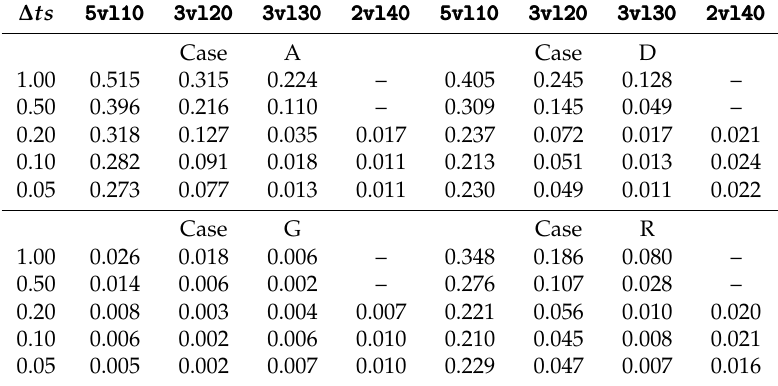
Table 4. Euclidean norms of the difference between the flow front in the physical [19] and numerical model with different spatial and temporal discretization. The cases differ in their composition of particle sizes in the suspension: Case A d = 25µm; Case D d 1 = 25µm, d 2 = 69µm; Case G d = 69µm and Case R d 1 = 17µm, d 2 = 37µm, d 3 = 63µm, d 4 = 88µm, d 5 = 105µm. In cases including more than one grain size the total sediment concentration is uniformly distributed across all